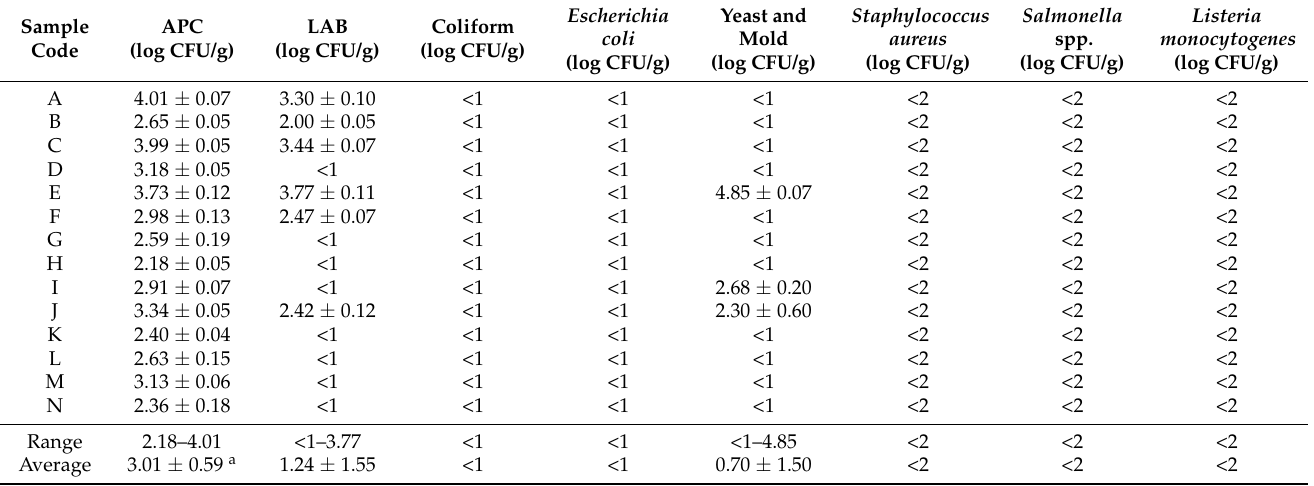
Table 1. Aerobic plate count (APC), lactic acid bacteria count (LAB), coliform, Escherichia coli , yeast and mold, and pathogens ( Staphylococcus aureus , Salmonella spp., Listeria monocytogenes ) in mustard pickle products from retail